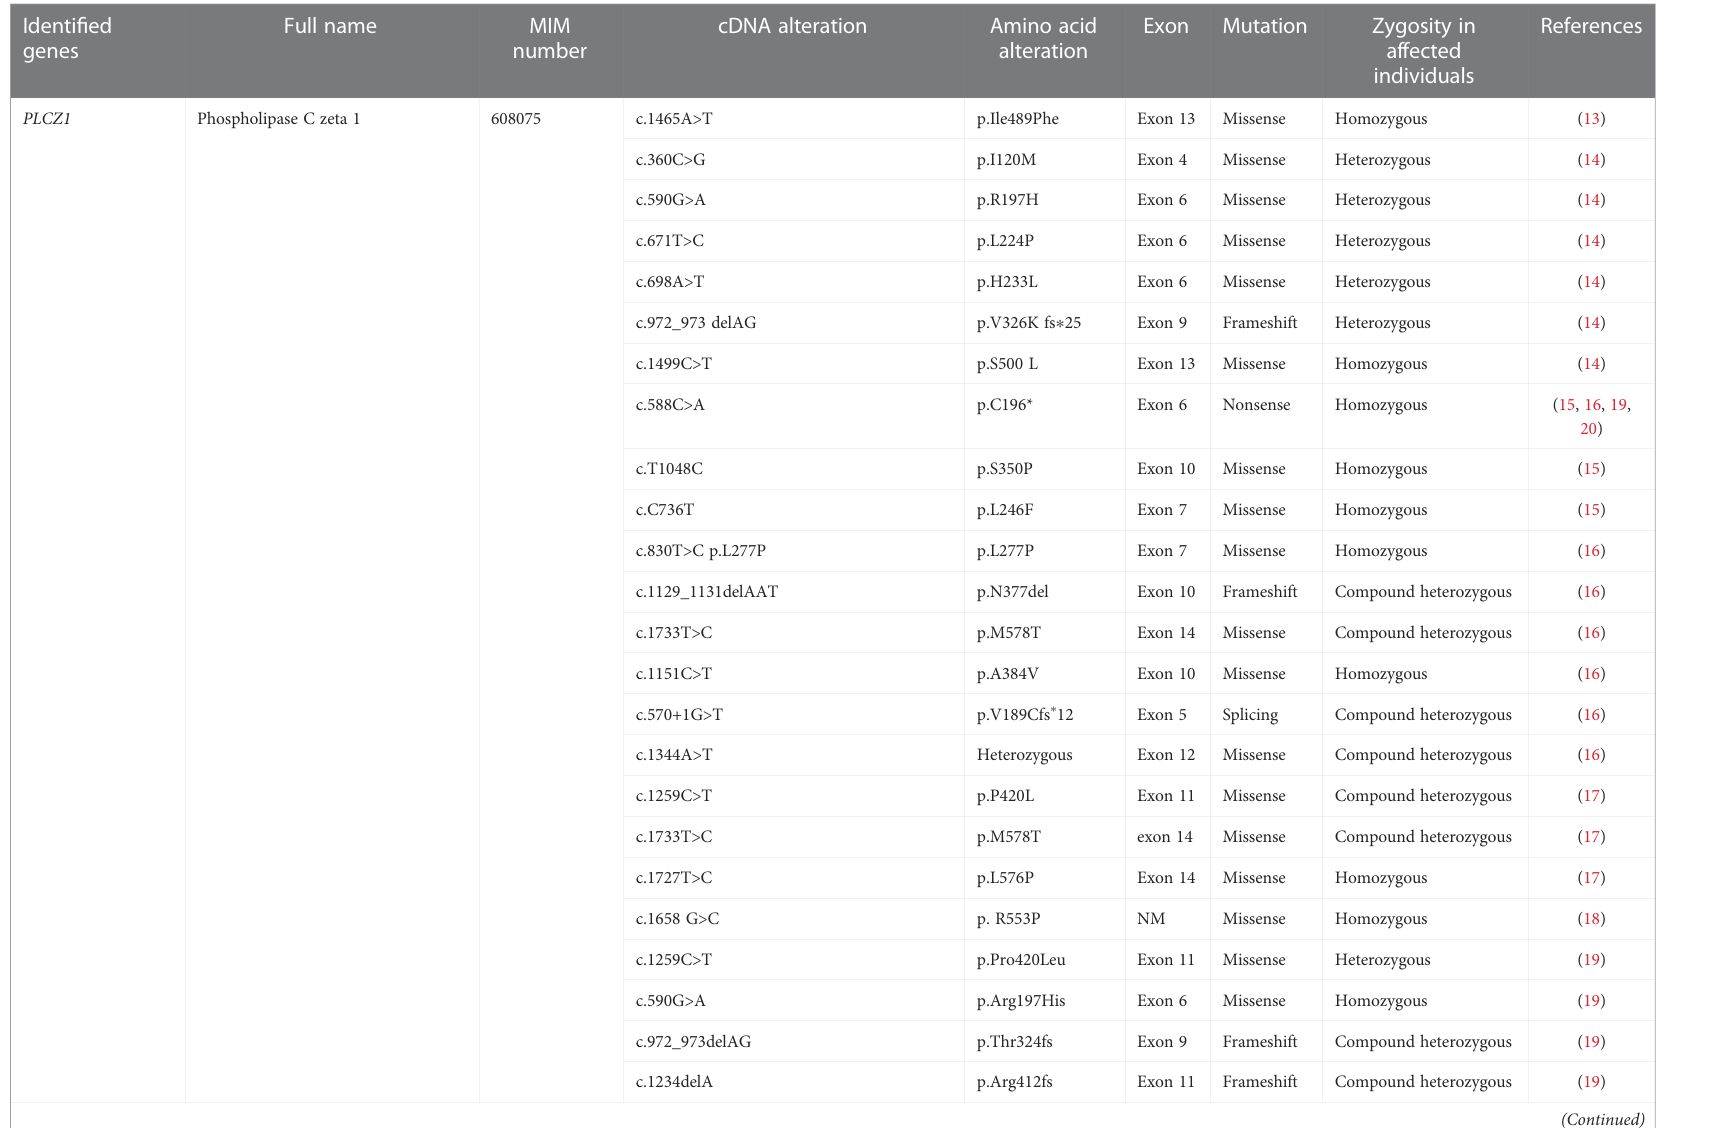
TABLE 2 Genetic mutations associated with poor or failed fertilization after IVF/ICSI by WES and Sanger sequencing